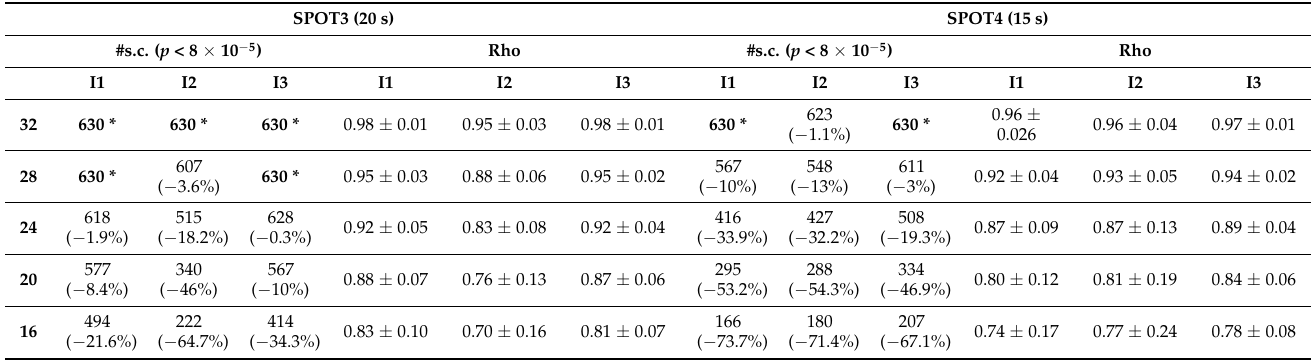
Table 3. Number of significant correlations (#s.c.) and eventual decrease as percentage of the total number of combinations (630), median ± std of rho values for the three indices (I1, I2, I3), and the five subgroups of subjects (32, 28, 24, 20, 16) during SPOT3 and